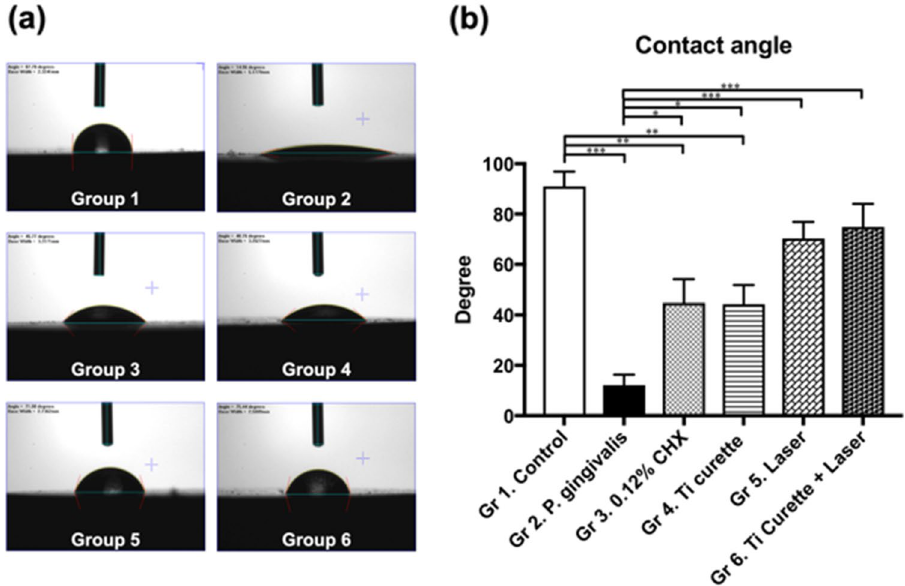
Figure 1. ( a ) Contact angle photos of P. gingivalis biofilm inoculation on titanium discs after different treatments. ( b ) Contact angle of P. gingivalis biofilms after different treatment. * p < 0.05 ** p < 0.01 *** p <